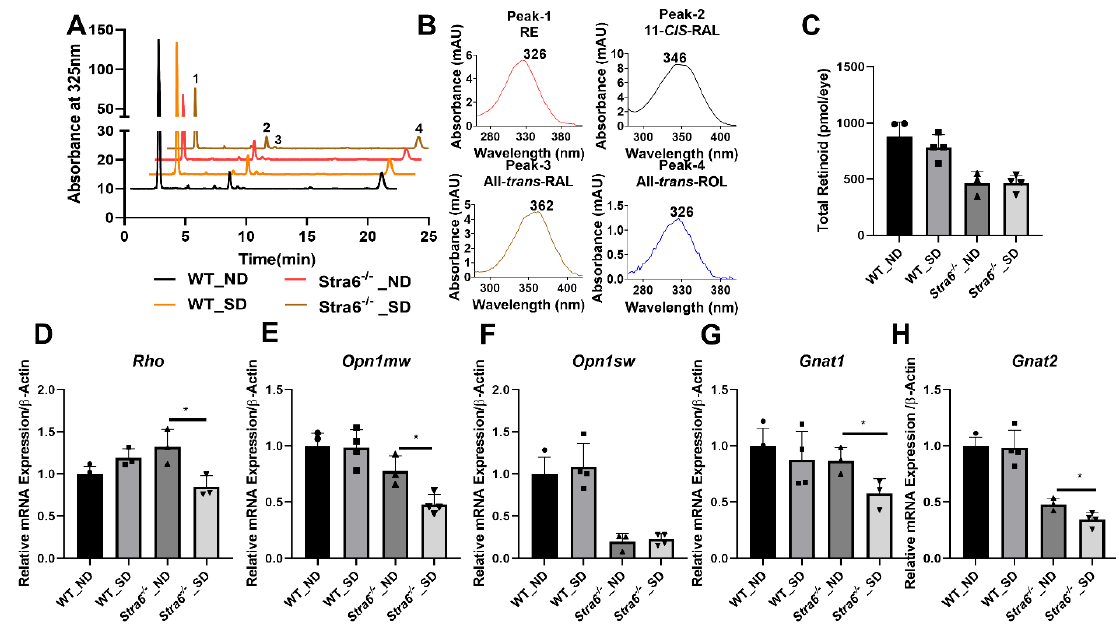
Figure 6. Ocular retinoid level and gene expression for rod and cone opsins. ( A ) HPLC trace at 325nm of ocular lipid extracts of long-term diabetic and non-diabetic WT and Stra6 -/- mice. Note that the retinal diastereomers were converted to the corresponding retinal oximes and exist as syn and anti stereoisomers. ( B ) Spectral characteristics of individual retinoids: RAL, retinaldehyde, RE, retinyl ester, ROL, retinol. ( C ) Total ocular retinoid concentrations. Quantitative RT-PCR analysis of genes of phototransduction machinery. ( D ) Rho mRNA levels. ( E ) Opn1mw mRNA levels. ( F ) Opn1sw mRNA levels. ( G ) Gnat1 mRNA levels. ( H ) Gnat2 mRNA levels in non-diabetic (ND) and diabetic (SD) WT and Stra6 -/- mice. β -Actin gene was used as an internal control. Values were normalized to the corresponding values of age-matched WT mice and are displayed as mean ± SD of three to four eyes per genotype and condition. The statistical analysis was performed using an unpaired two-tailed student’s t est. * p < 0.05.